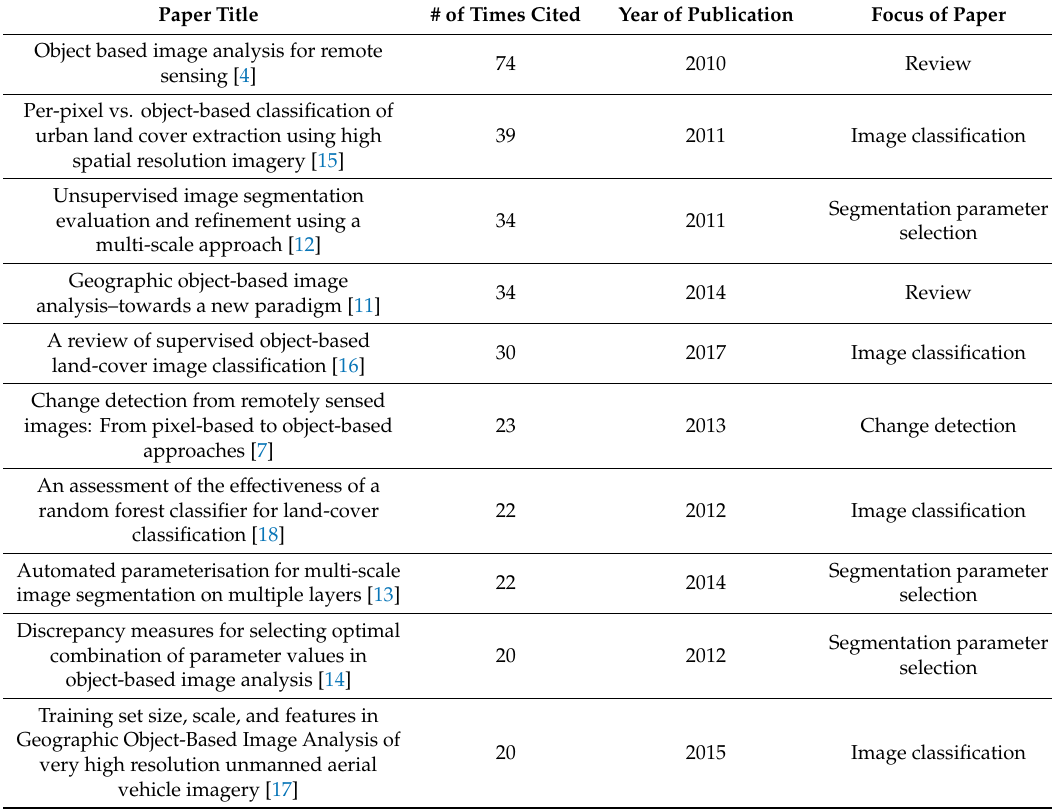
Table 1. Ten most frequently cited papers in recent articles on GEOBIA (based on an analysis